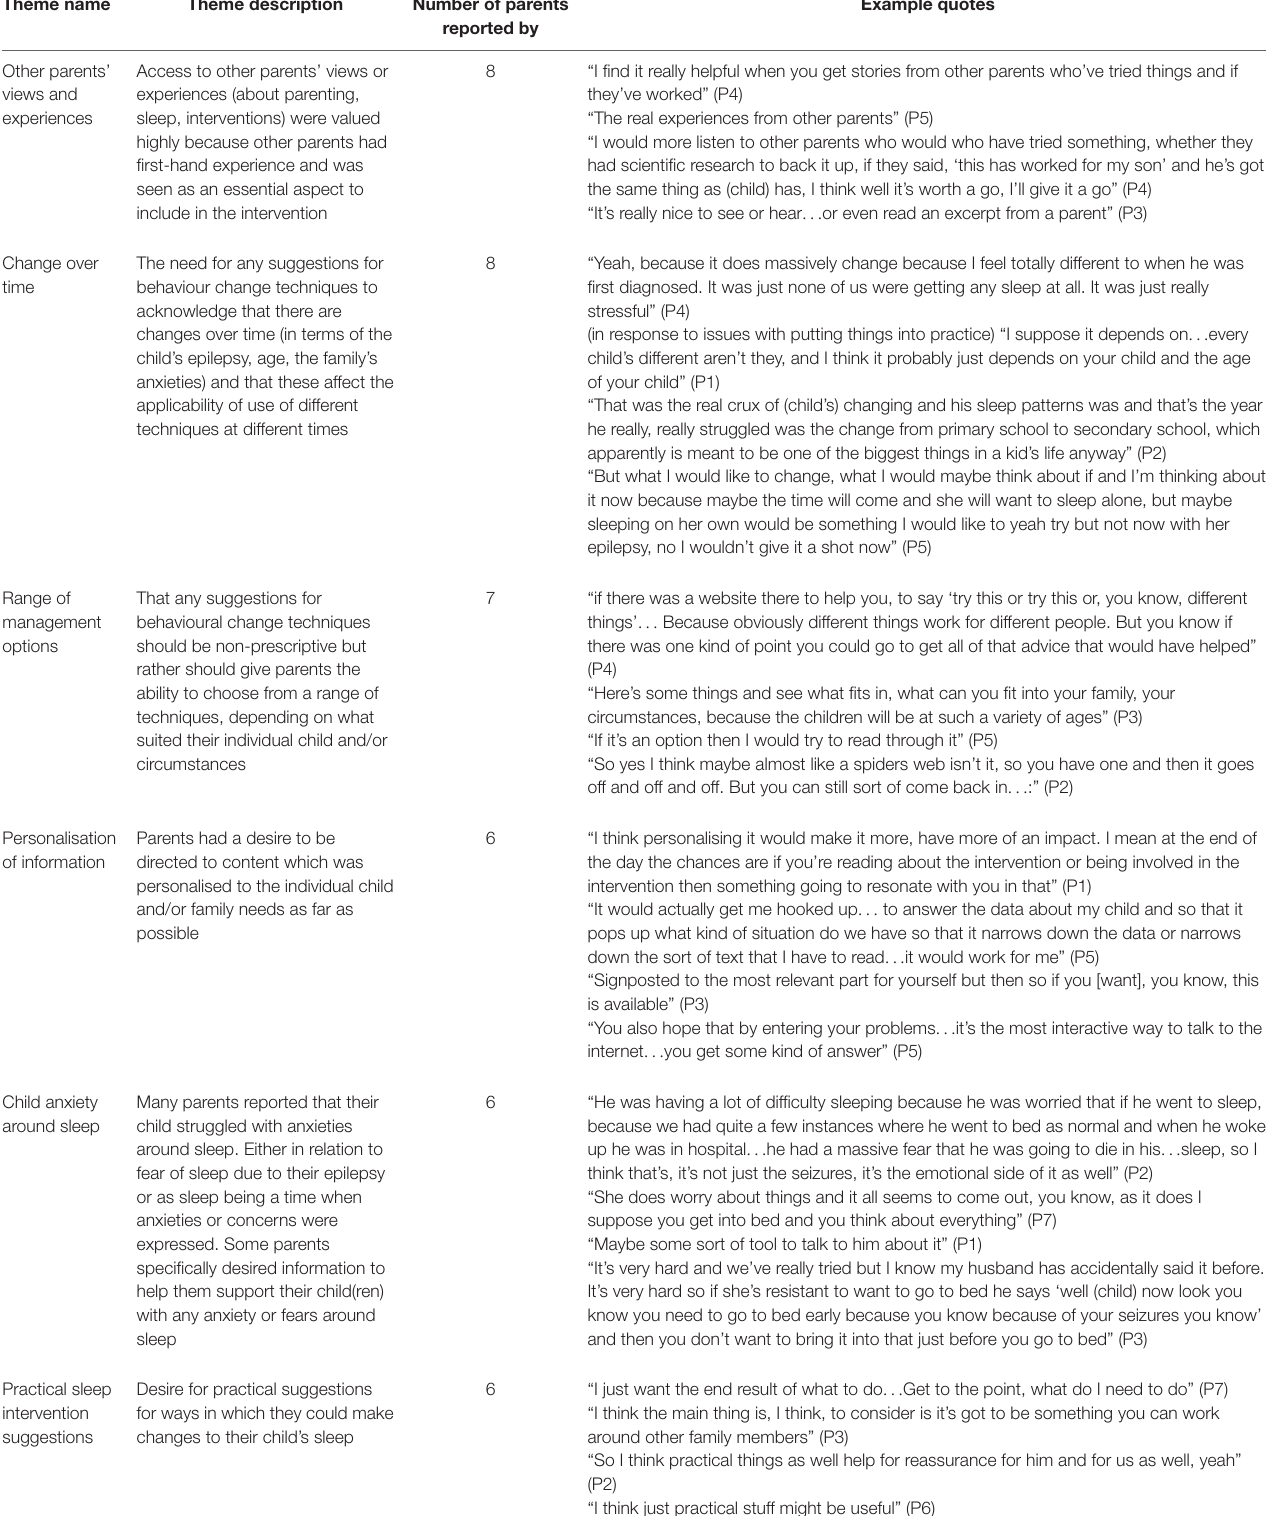
TABLE 3 | Themes, description, frequency count and supportive quotes of what parents wanted to be included in an online BSI for parents of CWE (based on n = 9 parents). Theme name Theme description Number of parents